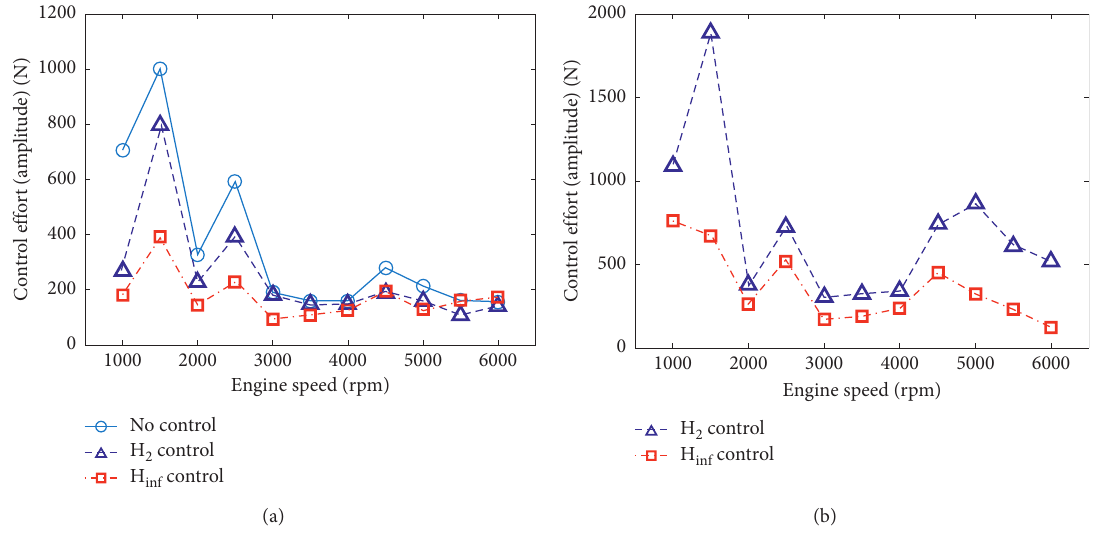
Figure 20: Control performances